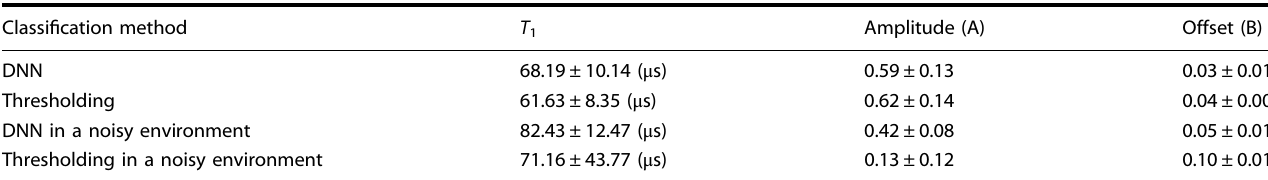
Table 2. T 1 times and fi tting parameters extracted from spin relaxation measurements using DNN classi fi cation or